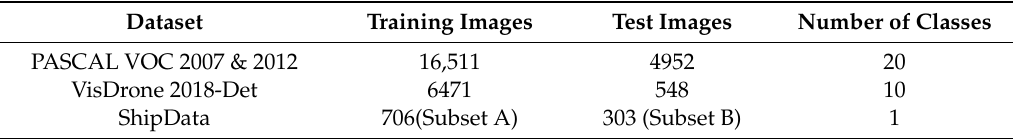
Table 3. Overview of PASCAL VOC and VisDrone